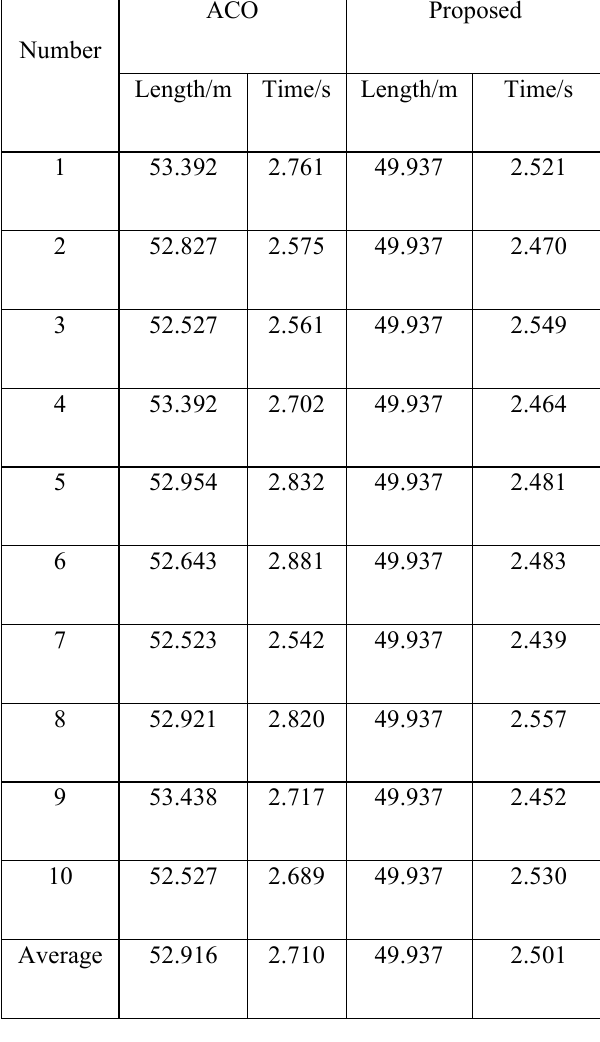
Table 1. Performance comparison between traditional ant colony algorithm and the